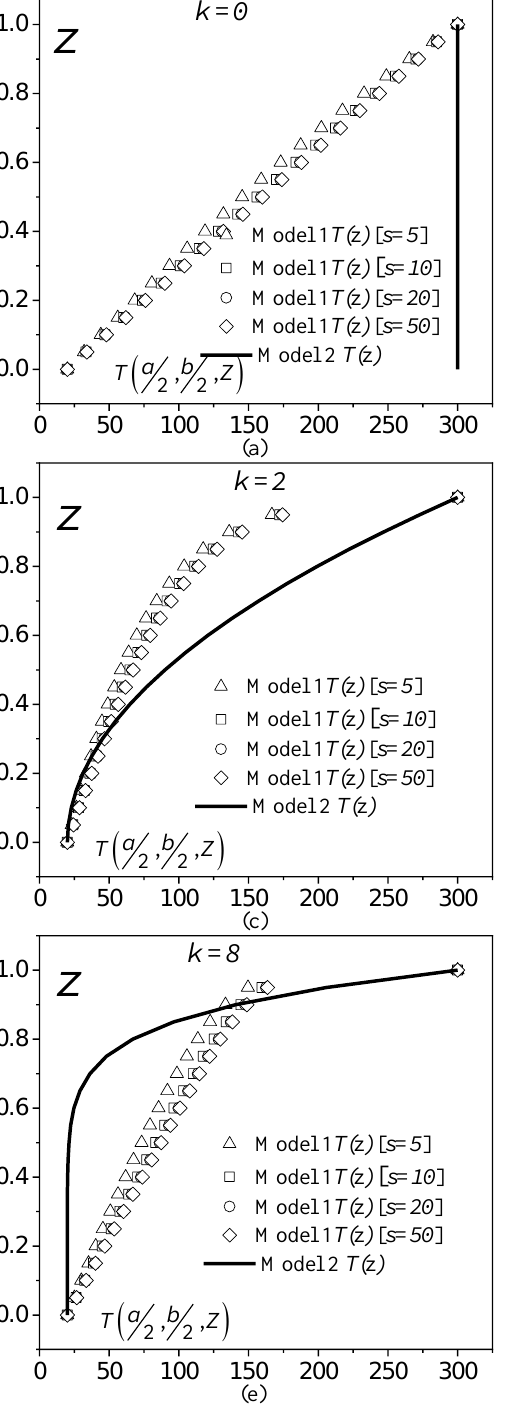
Fig. 2. Comparison between through thickness exact temperature variation and power law variation for different power index ( k) for square laminate material set